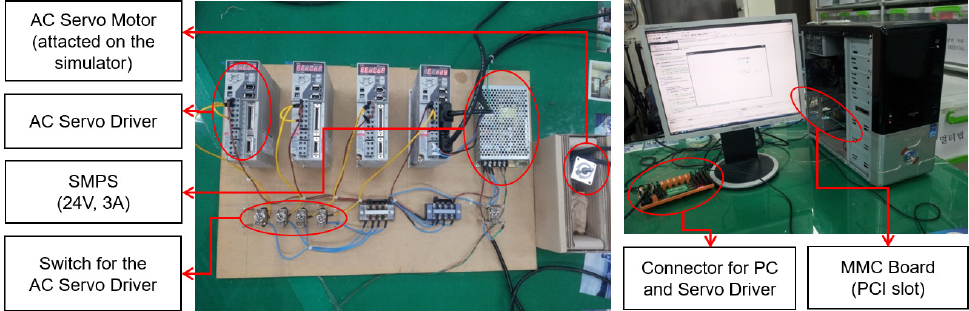
Figure 13. Control System configuration for downscaled hot rolling simulator.